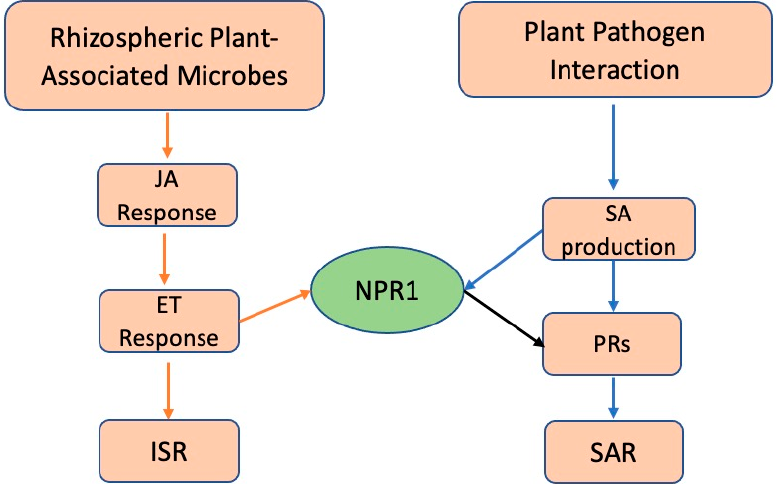
Figure 2. Schematic representation of the common signal-transduction pathways leading to pathogen-induced systemic acquired resistance (SAR) and rhizosphere-mediated induced systemic resistance (ISR) inspired by [114] for Arabidopsis thaliana but applicable to plants in general. Crosstalk between the two pathways occurs through the activation of NONEXPRESSOR OF PATHOGENESIS-RELATED GENES1 (NPR1). Non-pathogenic plant-associated microbes, usually from the rhizosphere, can trigger the SAR pathway as well as ISR. In the rhizosphere-mediated ISR pathway, components from the jasmonic acid (JA) and ethylene (ET) responses act in sequence to activate a systemic resistance response (orange arrows). Pathogenic agents could activate the pathogen-induced SAR, through the activation of NPR1 (blue arrows), leading to the expression of PATHOGENESIS-RELATED genes (PRs) (black arrow). NPR1 also mediates crosstalk between the SA signaling pathway.